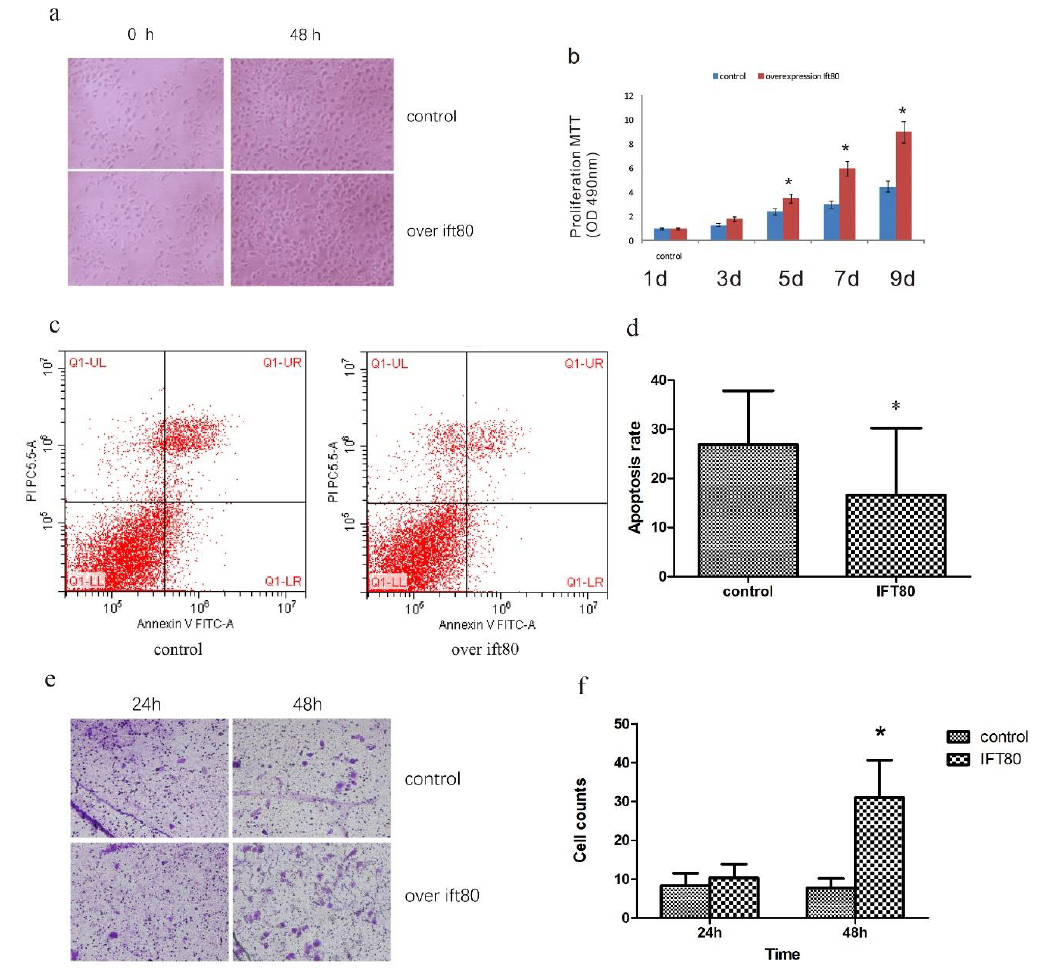
Figure 3. Overexpression of IFT80 enhances the proliferation and invasion potential of SGC-7901 cells, and inhibits apoptosis. ( a ) Top panel, images represent transfection control of the empty vector, 0 h and 48 h. Bottom panel, SGC-7901, the gastric cancer cells transfected with the IFT80 plasmid at 0 h and 48 h (200×). ( b ) Cell proliferation is determined by the CCK-8 assay ( N = 3, * P < 0.05, control vs. overexpression of ift80). ( c ) Flow cytometric analysis of apoptotic cells using the annexin V-FITC reagent. Overexpression of IFT80 inhibits apoptosis in SGC-7901 cells. ( d ) Quantification of images shown in ( c ). ( e ) Transwell migration assay analysis the of invasion ability of SGC-7901 gastric cancer cells. IFT80 overexpression promotes the invasion ability of SGC-7901 cells (200×). ( f ) Quantification of images shown in e. ( N = 3, * P < 0.05, control vs. overexpression of ift80).